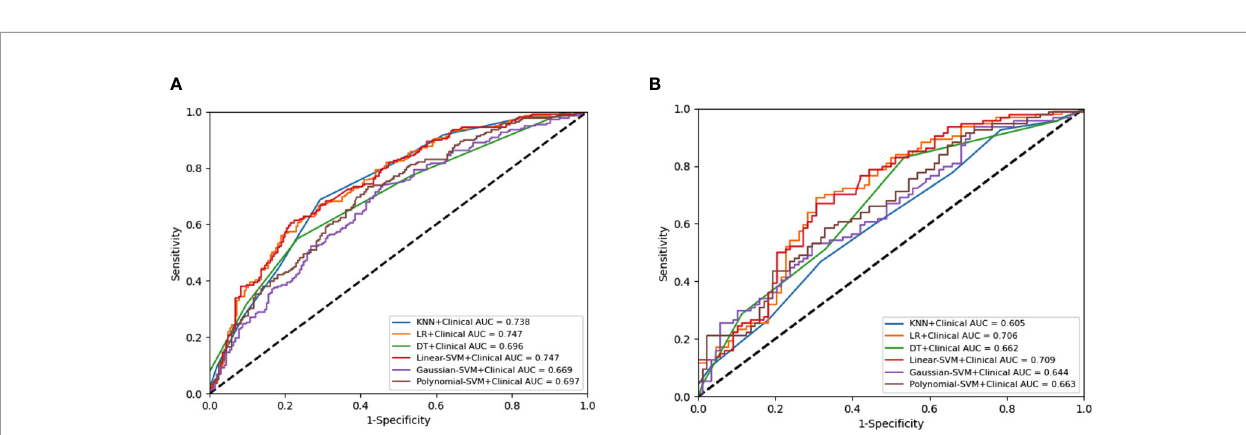
FIGURE 4 | Receiver operating characteristic (ROC) curves of the radiomics model constructed by six algorithms in the training set (A) and internal test set (B) .